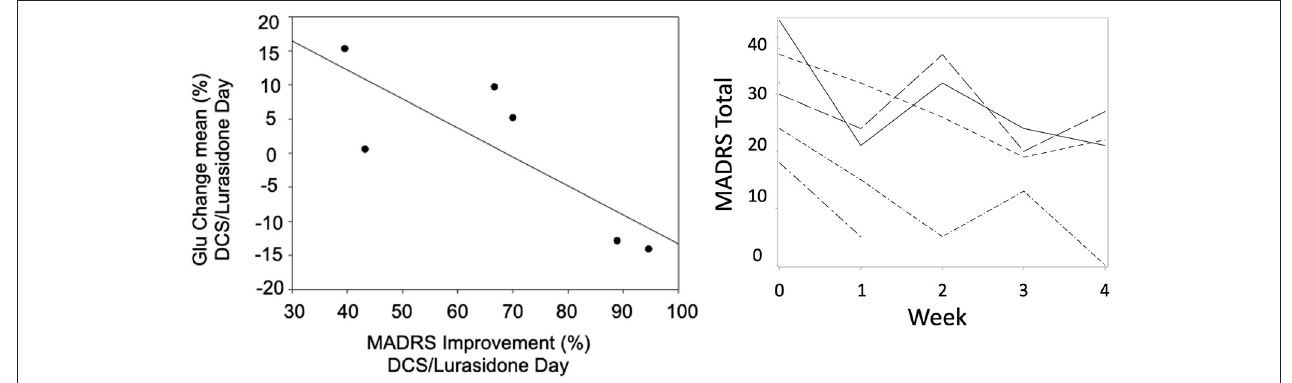
FIGURE 3 | A scatter plot of mean change in Glu vs. improvement from baseline MADRS (r s = − 0.83, p = 0.04) on the DCS/Lurasidone days (Left). Spaghetti plot of MADRS over time by subject